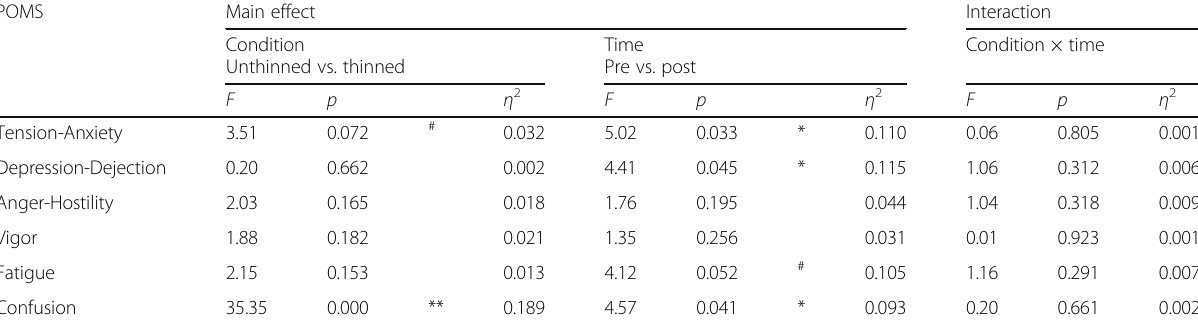
Table 7 Results of two-way repeated measures ANOVA for Profile of Mood States (mood) POMS